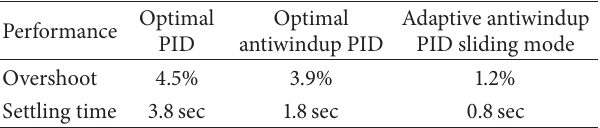
Table 5: Comparison of the performance of optimal PID, optimal antiwindup PID, and adaptive antiwindup PID sliding mode control systems with load